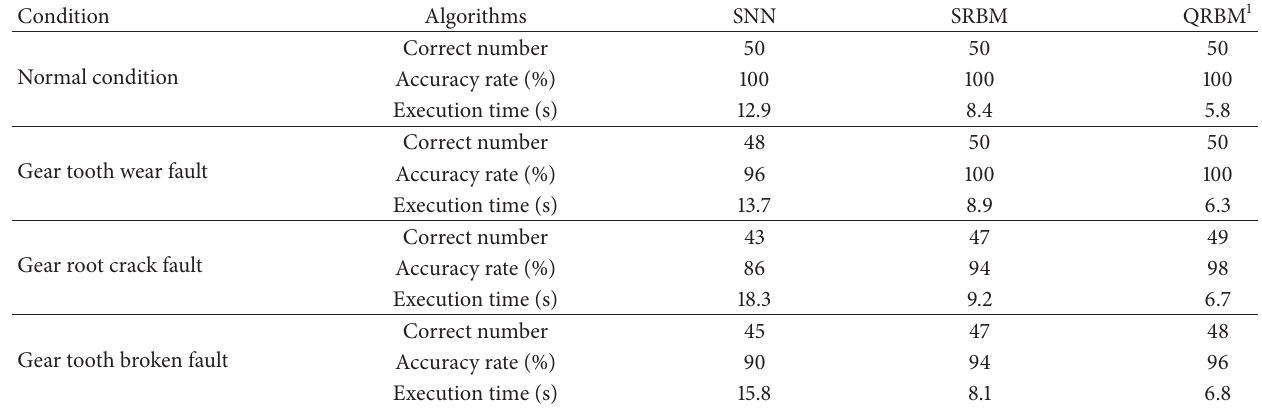
Table 1: Comparison results of pattern recognition for gear